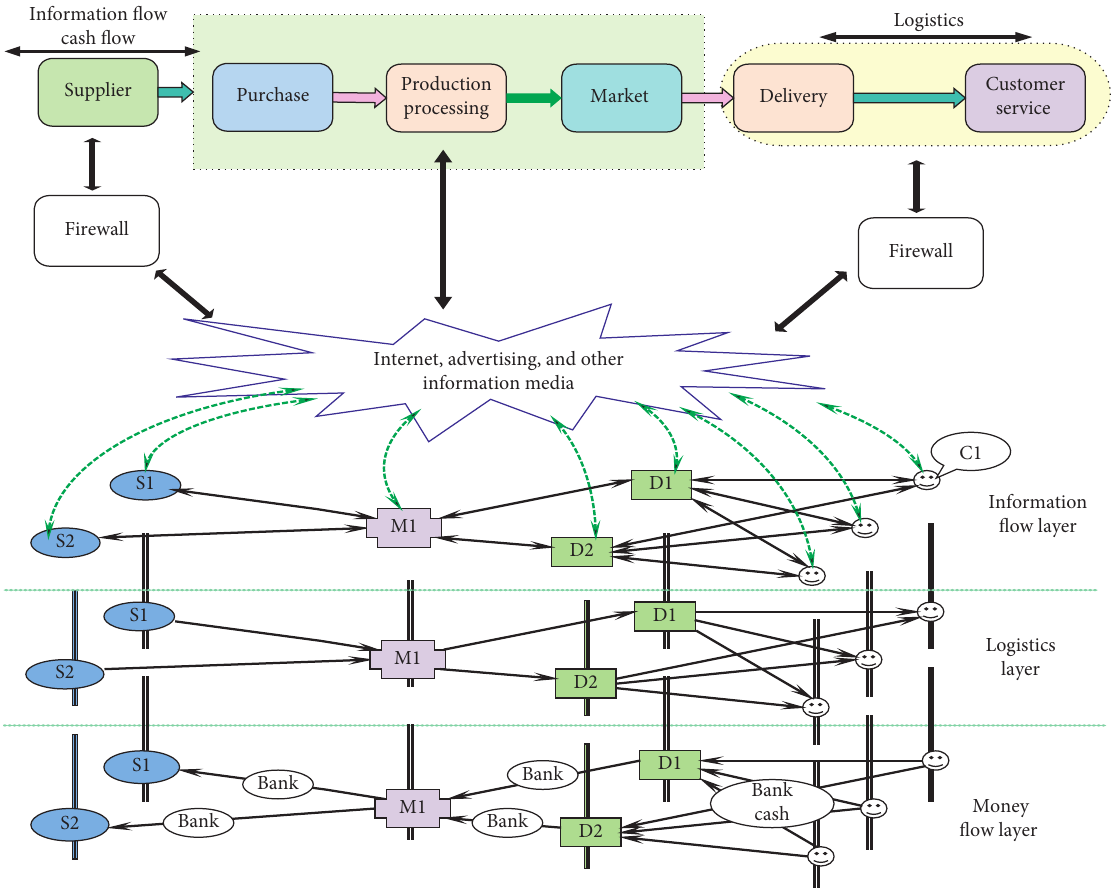
Figure 5: Supply chain management optimization in e-commerce